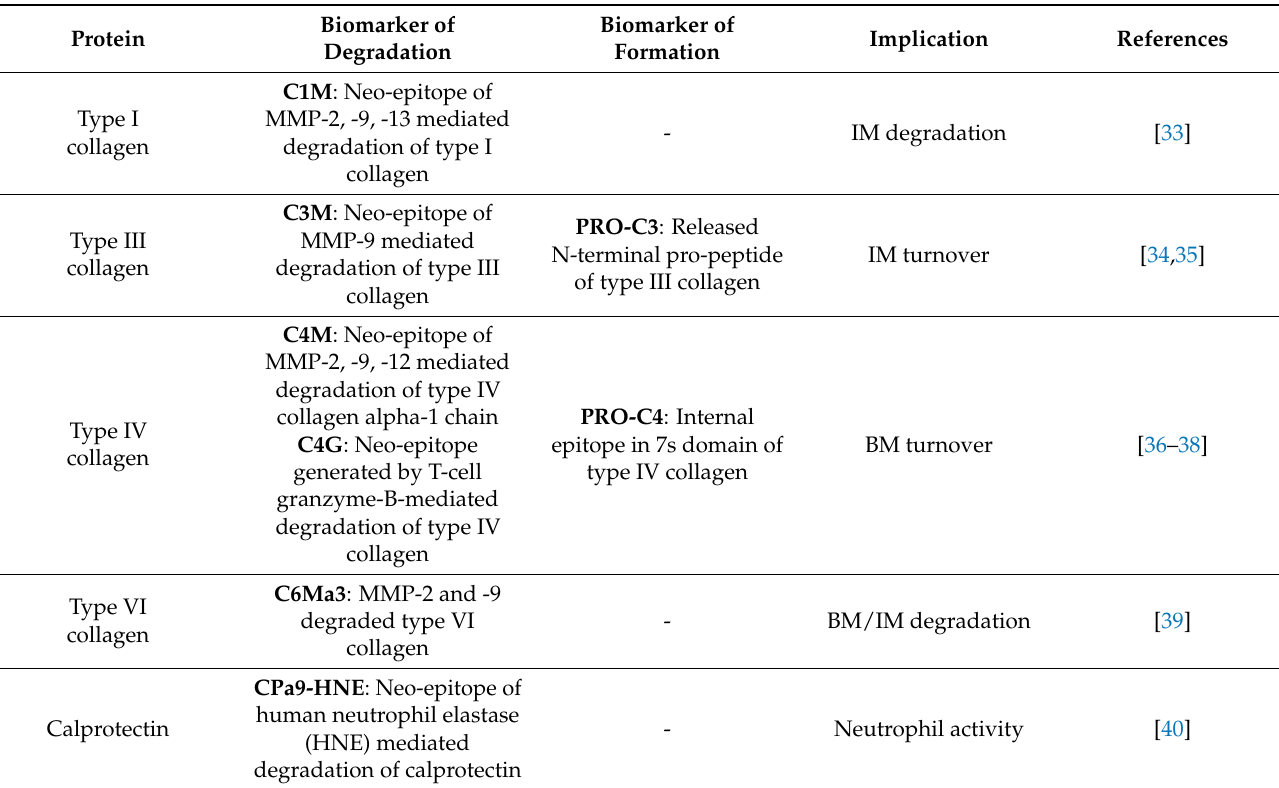
Table 5. Serological biomarkers of extracellular matrix formation/degradation, intestinal inflamma- tion, and immune cell activity measured in this